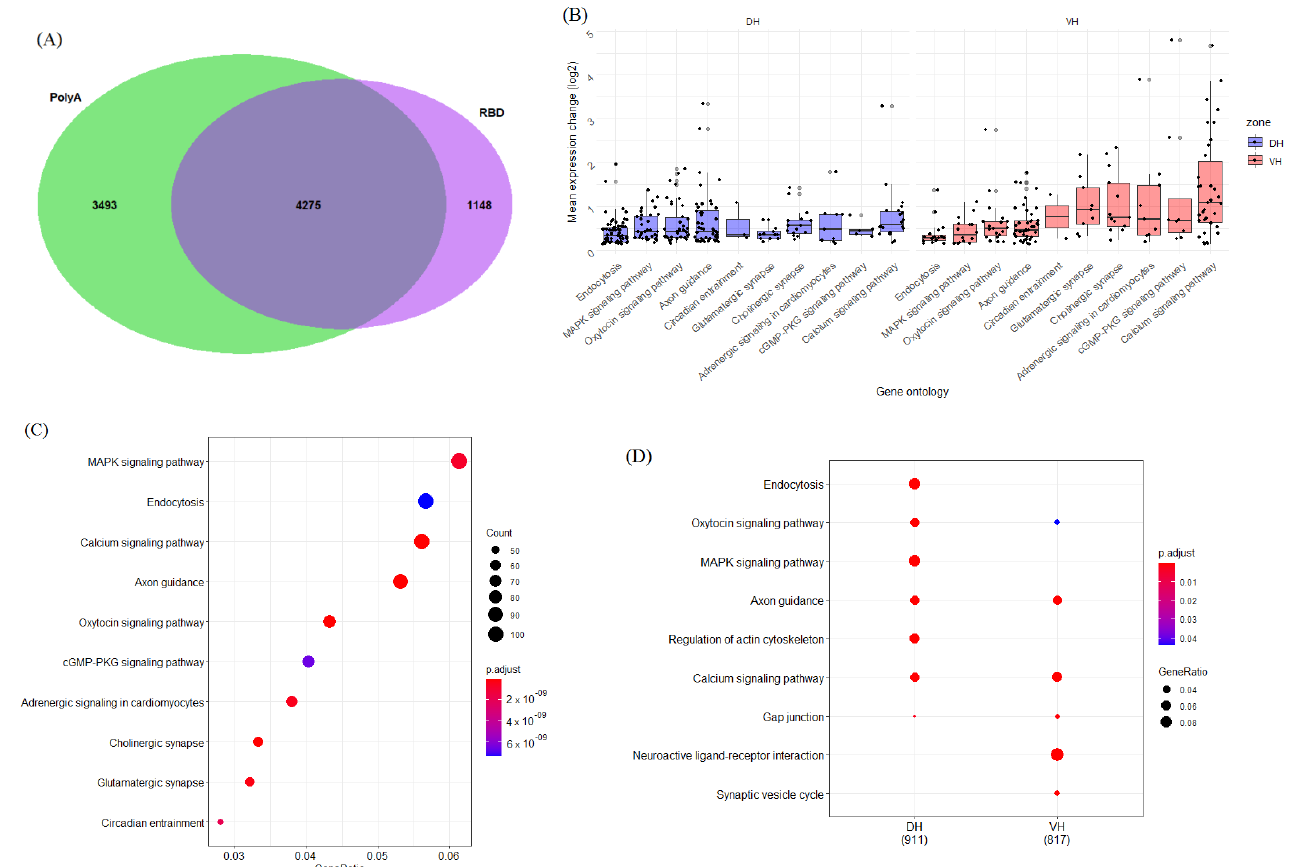
Figure 1. ( A ) Intersection between genes differentially expressed (dorsal vs. ventral hippocampus (DH vs. VH)) in PolyA and RBD datasets. ( B ) Top 10 DH- and VH-dominant (blue, red) gene ontology categories for PolyA/RBD intersection gene set. X axis represents ontology category; Y axis, log 2 fold change, averaged across all genes in the group. ( C ) Plot showing top 10 most significant KEGG categories for PolyA/RBD intersection gene set (4275). ( D ) Plot showing statistical comparison of KEGG category enrichment in Ventral (VH) vs. Dorsal (DH) gene lists.